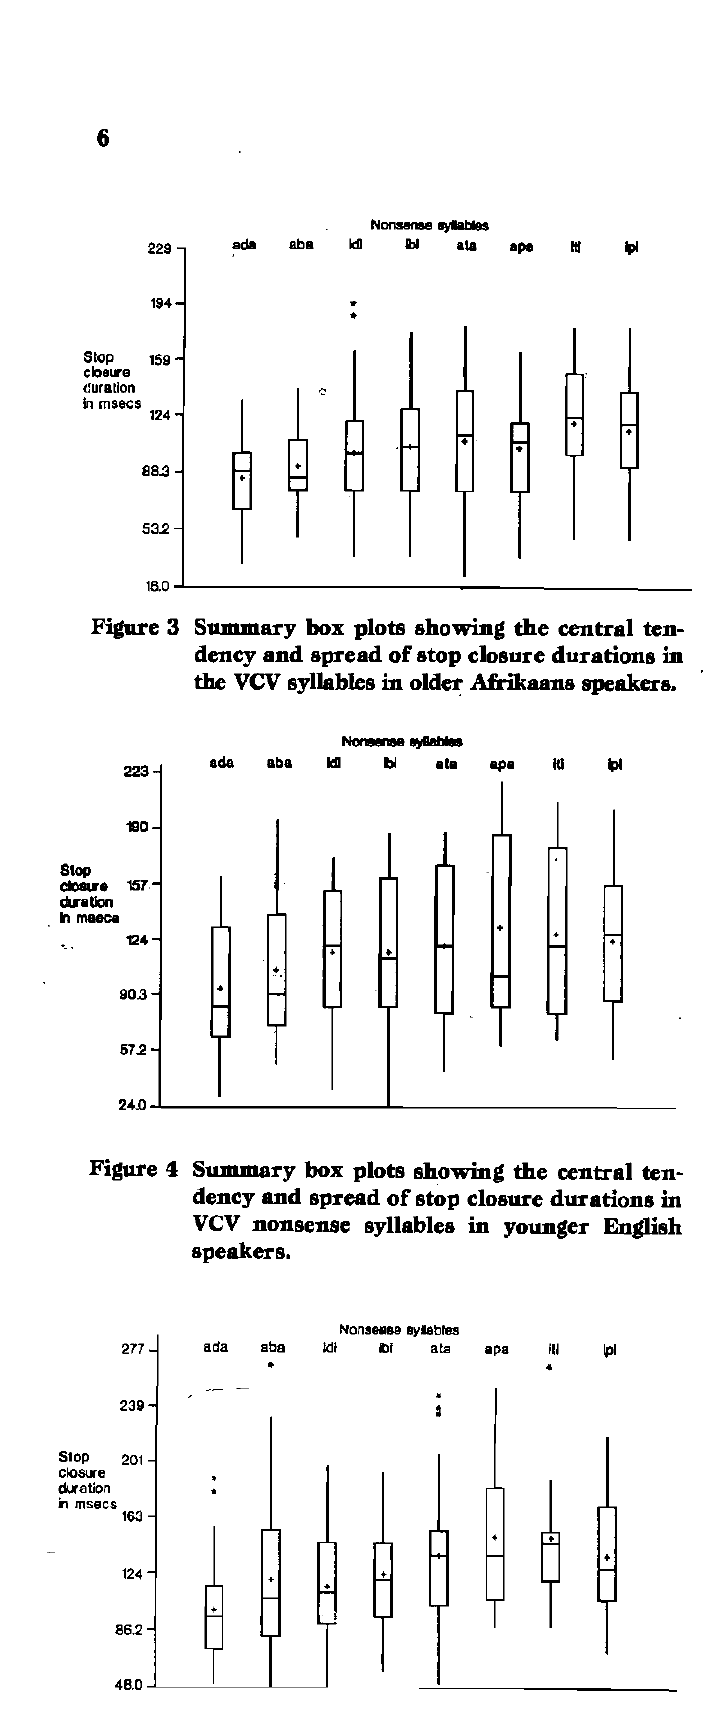
Figure 5 Summary box plots showing the central ten- dency and spread of stop closure durations in VCV syllables in younger Afrikaans